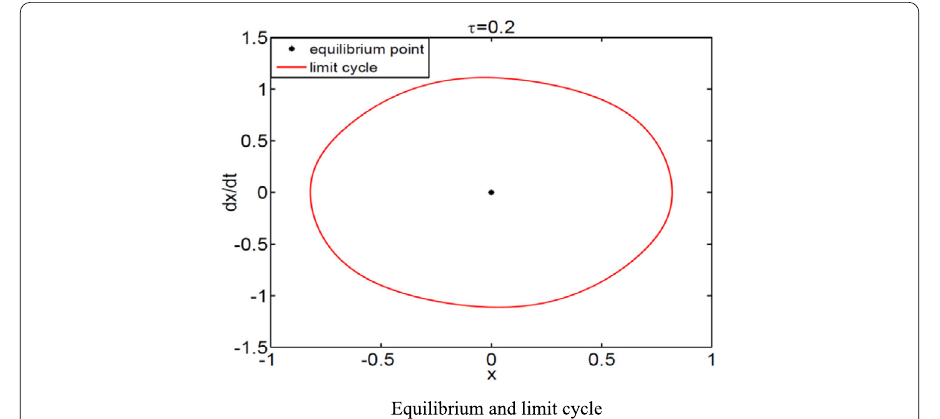
Figure 4 Phase diagram of the deterministic system (at τ =